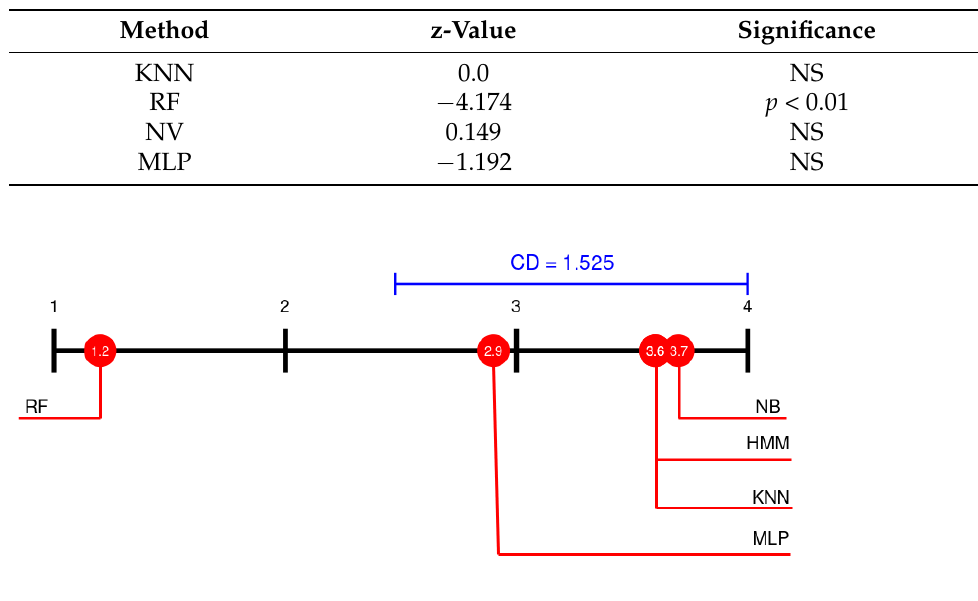
Figure 11. Comparison of the performances of methods using the Nemenyi test. CD is critical distance.